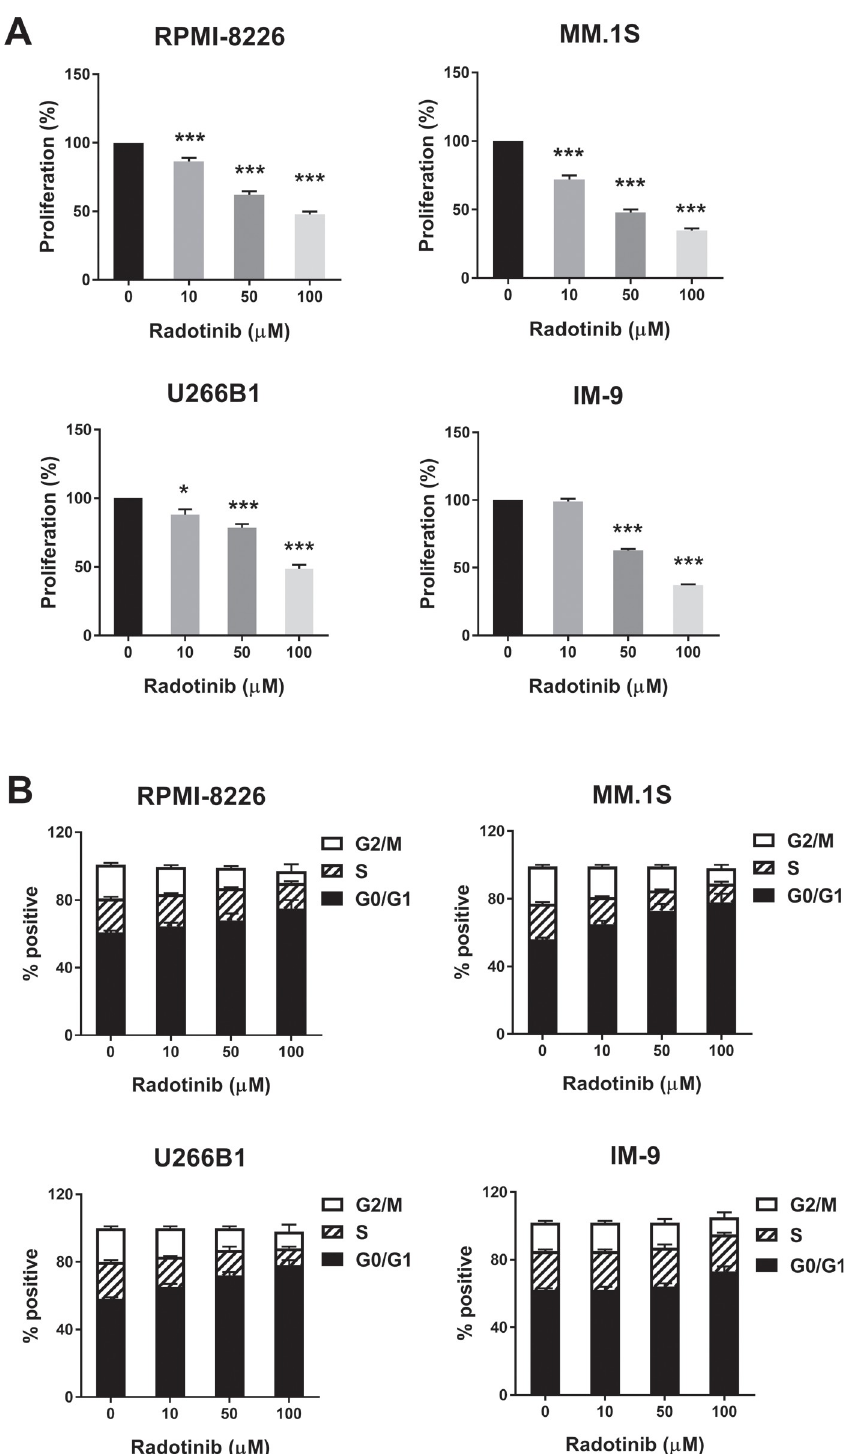
Fig 2. Radotinib inhibits MM cell proliferation, while augments G0/G1 phase cell cycle arrest in the four types of MM cells. (A) Cell proliferation at 72 h after radotinib treatment. (B) Cell cycle distribution at 72 h after radotinib treatment. Cell proliferation and cell cycle distribution were measured as described in Methods The cells were also collected and treated under the same conditions described above. Data are presented mean ± SEM.; � , P < 0.05; and ��� , P < 0.001. � Significantly different from control